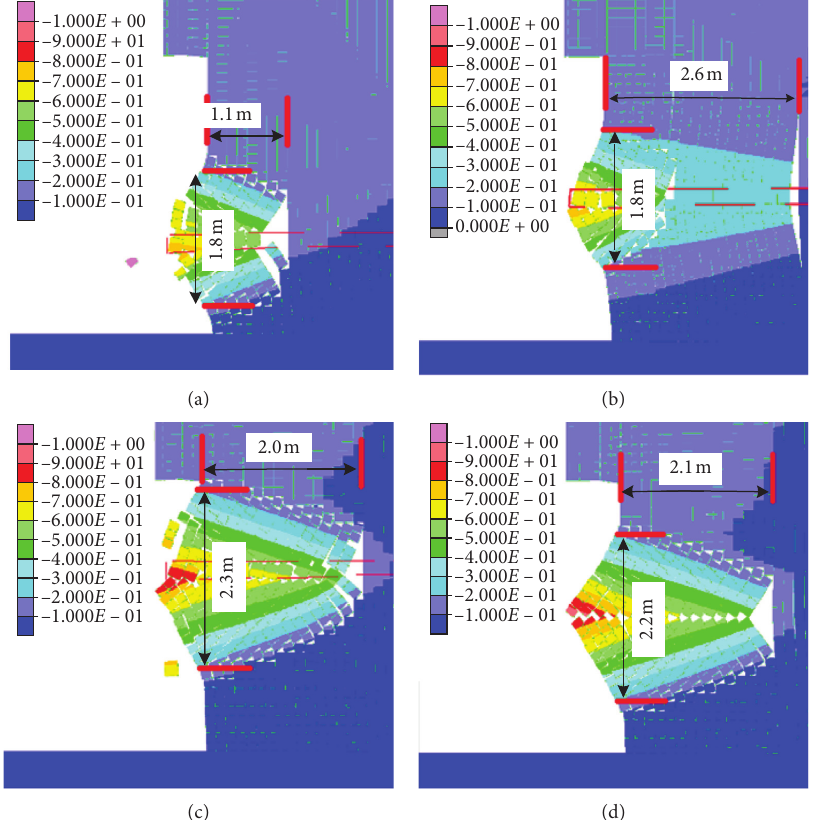
Figure 5: Cloud chart of horizontal displacement distribution in coal seam (m): (a) lower gangue; (b) middle gangue; (c) upper gangue; (d) without gangue.